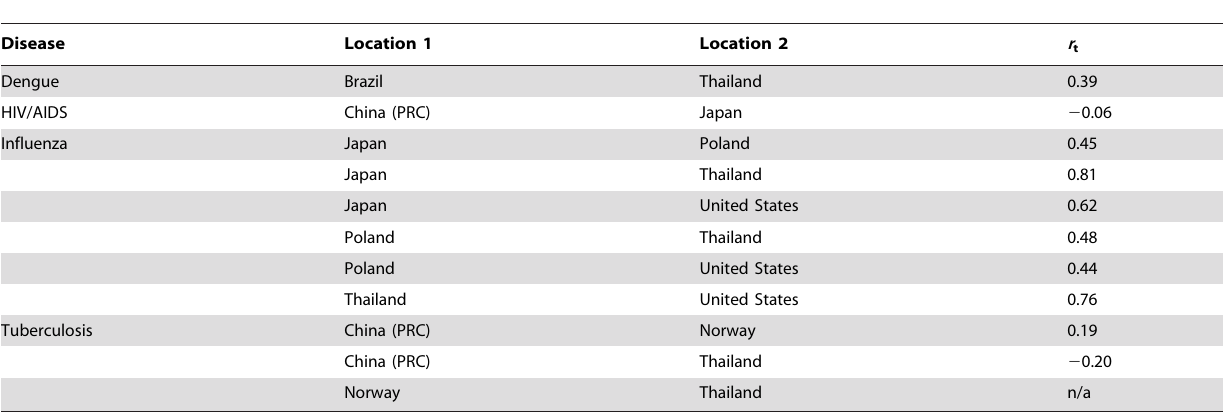
Table 4. Transferability scores r t for paired models.